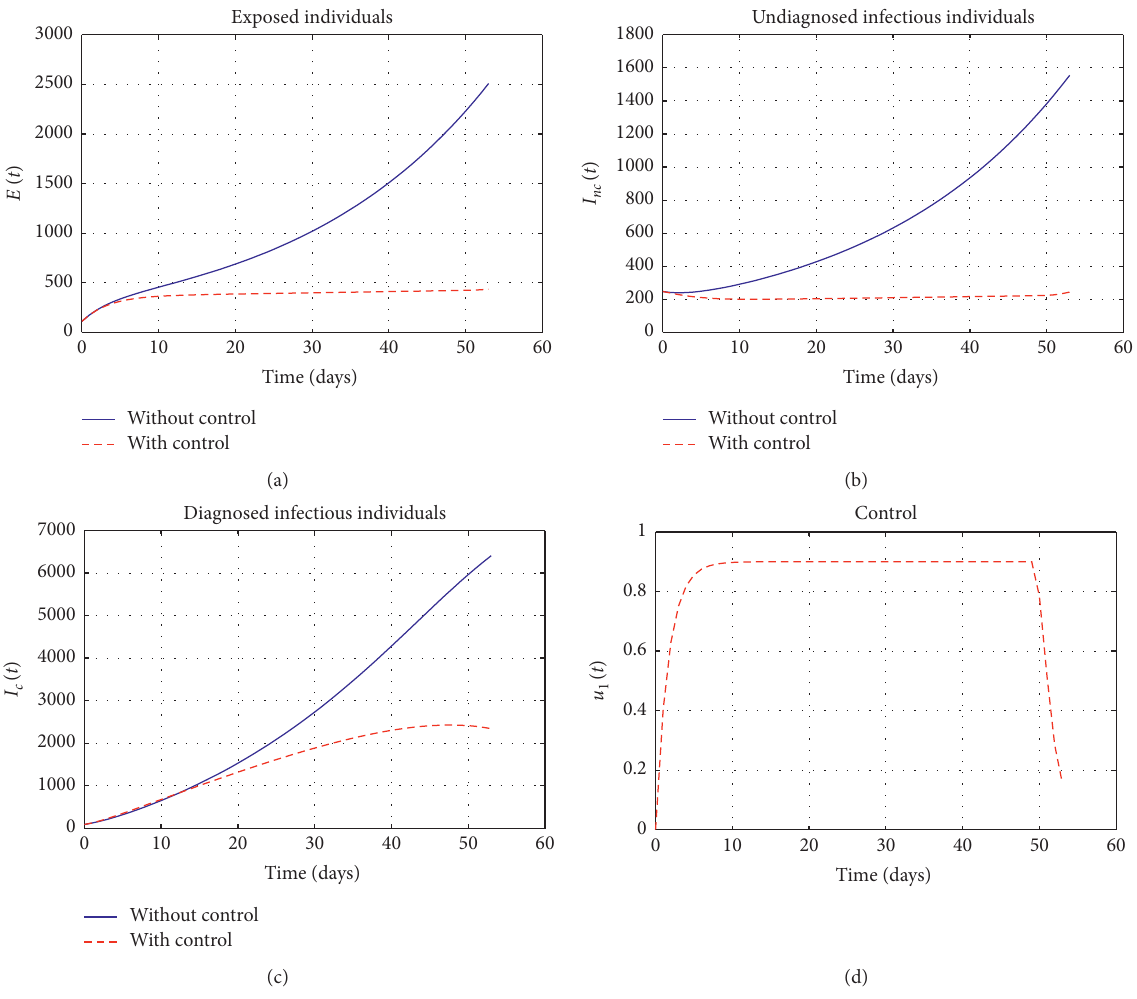
Figure 3: Number of E , I ( I nc ). (c) Confirmed and isolated individuals ( I c ). (d) Evolution of the control u